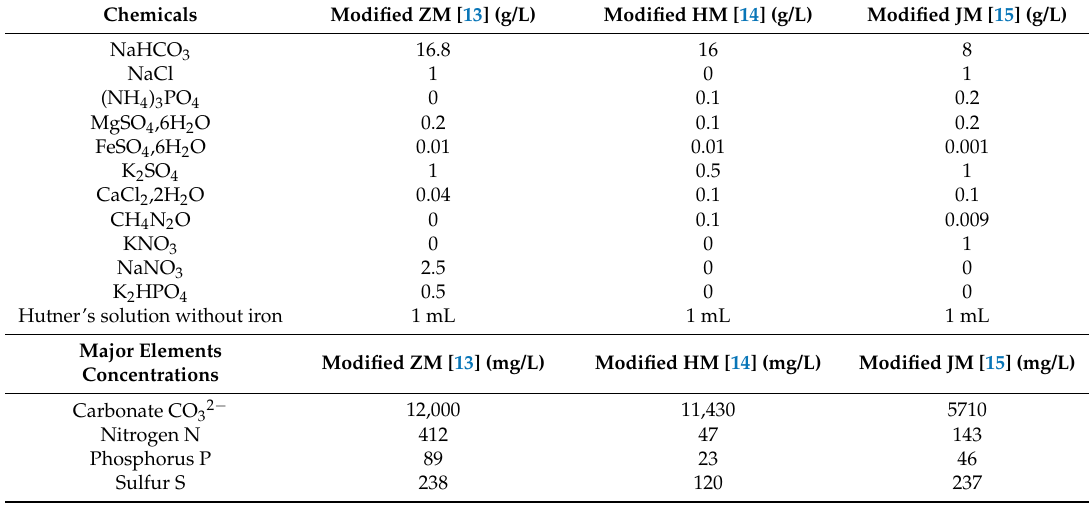
Table 1. Modified ZM, HM, and JM